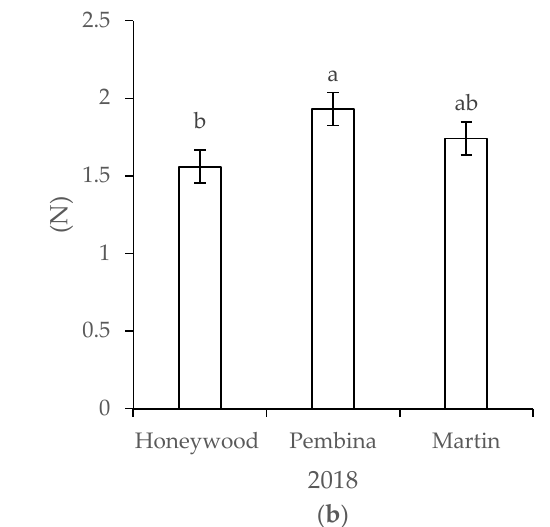
Figure 6. Fruit firmness of the studied cultivars in ( a ) 2017 and ( b ) 2018. Values with different letters are significantly different within a year.